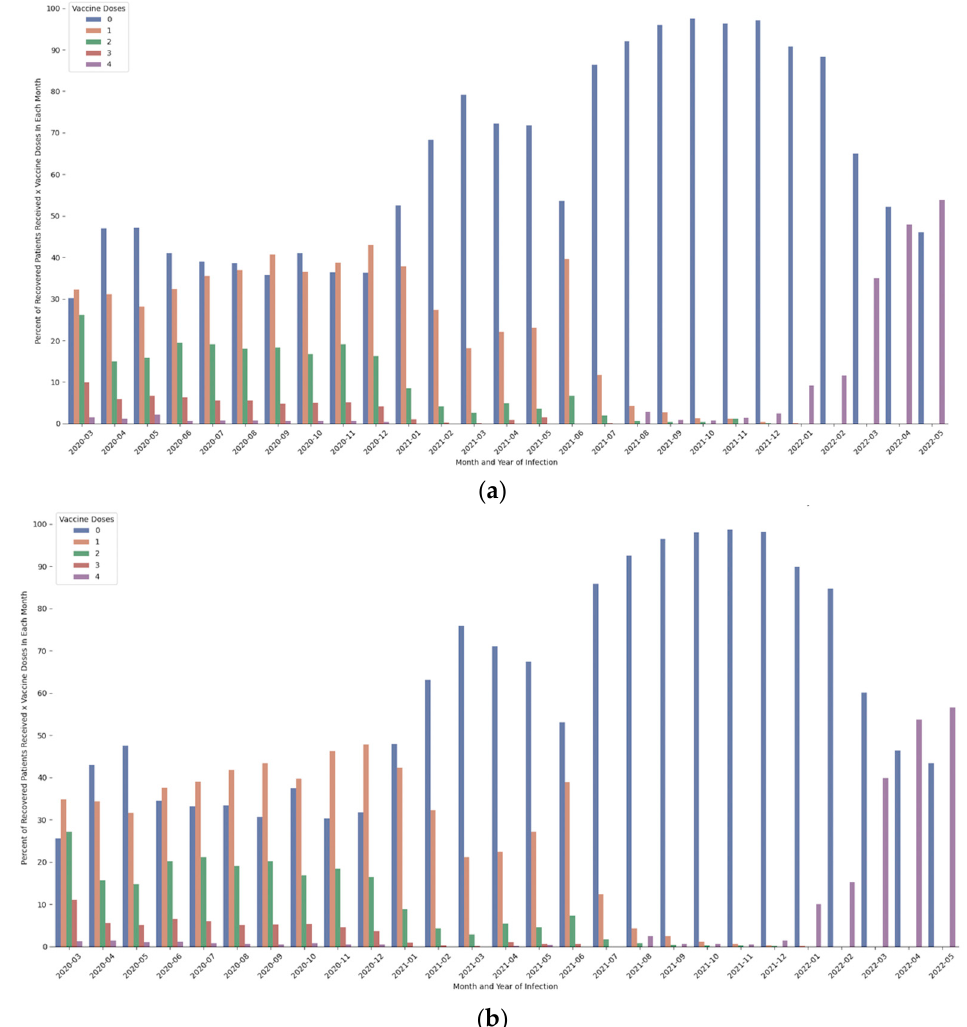
Figure 2. Per-month infection (year-month), percentage of recovered patients by gender (( a ) — male individuals; ( b ) — female individuals) according to number of vaccine doses received. Note: data only include recovered patients who received no vaccine doses prior to vaccination. Dose immunization rates are relatively low in young people 0–19 years old compared to older ages, 20–59 years and above the age of 60 (See Figure 3). A similar trend was observed in the second and booster doses (third and fourth) of vaccines, where response rates to immunization were significantly higher among the older population.